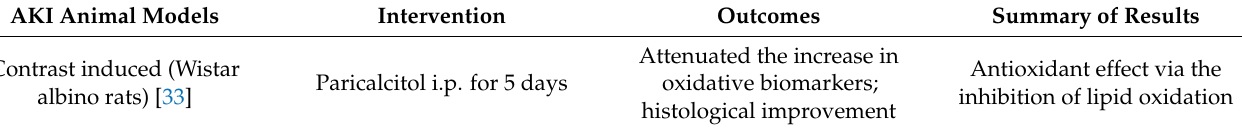
Table 1. Summary of the studies evaluating the effect of vitamin D therapy in AKI animal models.